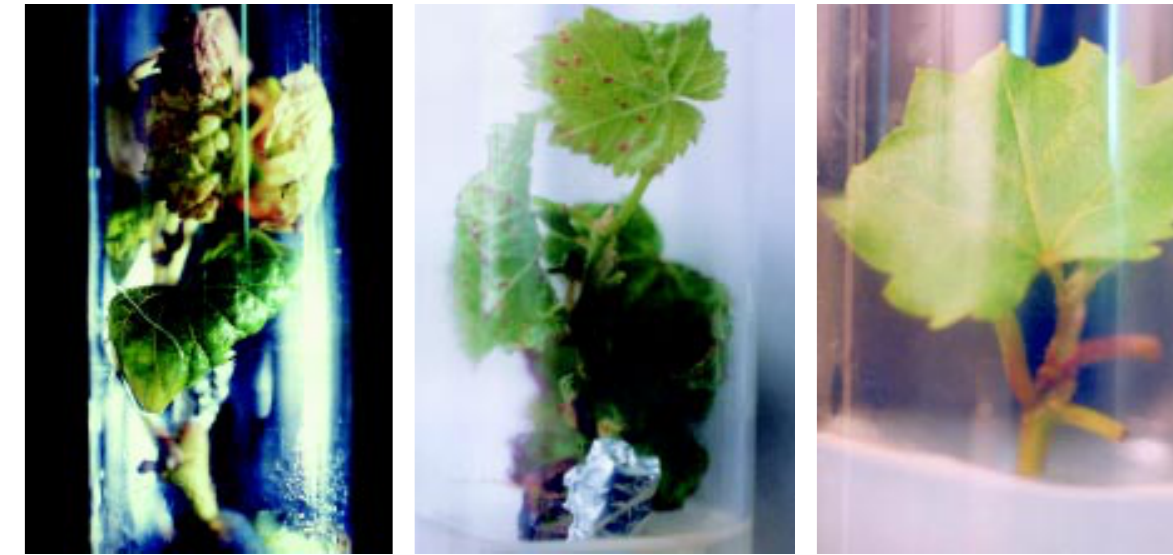
Fig. 3. Scattered red spots on Caber- net Sauvignon leaf blade as early symptom of leafroll.